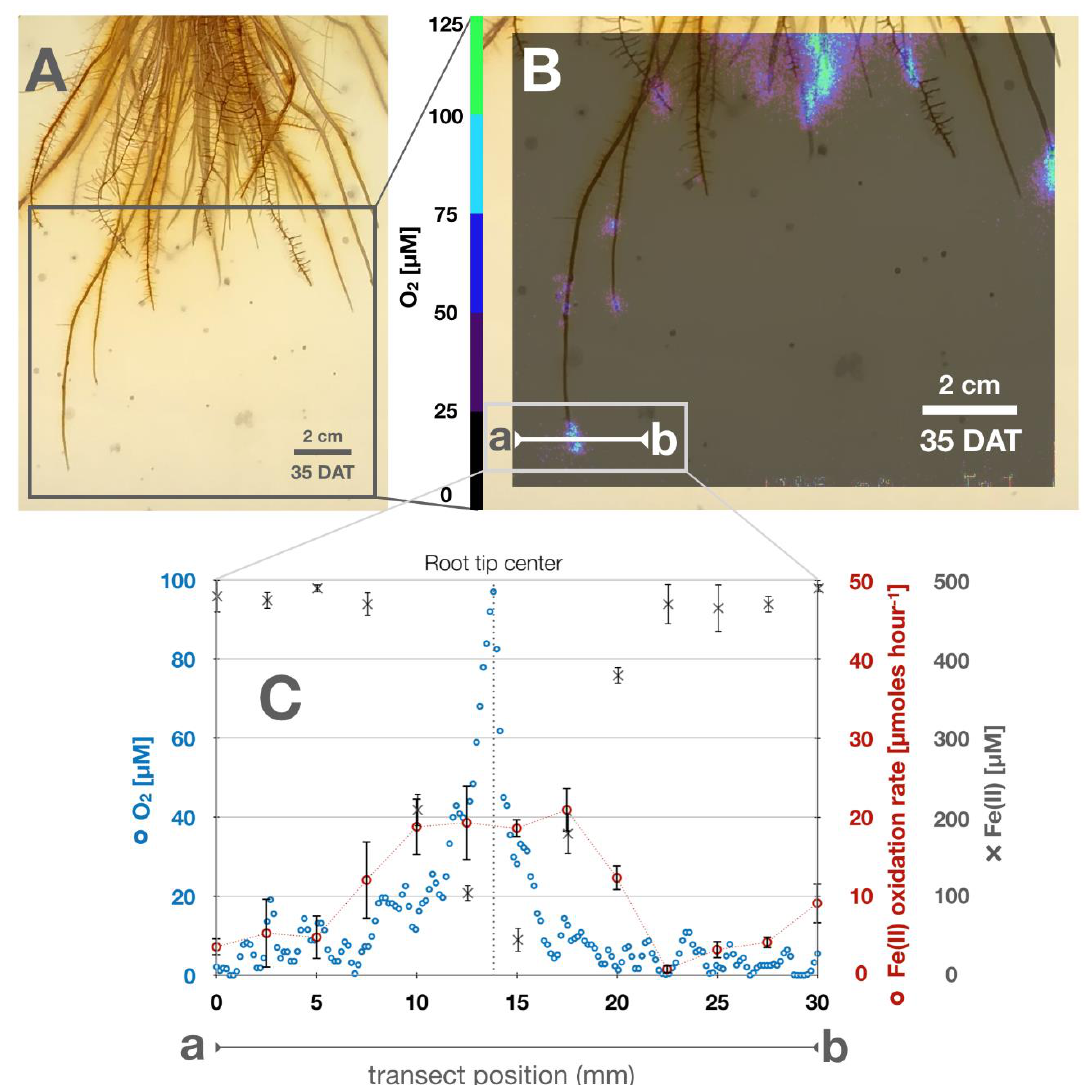
Figure 1. Radial oxygen loss and iron geochemistry at the root–soil interface at the end of light-incubated cycles: ( A ) Rice roots covered in iron plaque. ( B ) Radial oxygen concentrations surrounding root tips 35 DAT (DAT = days after transfer), a-b indicates a transect where O 2 and Fe(II) were measured and Fe(II) oxidation kinetics were calculated. ( C ) Transect a-b: representative concentrations of O 2 , Fe(II) and calculated homogeneous Fe(II) oxidation rate along transect.